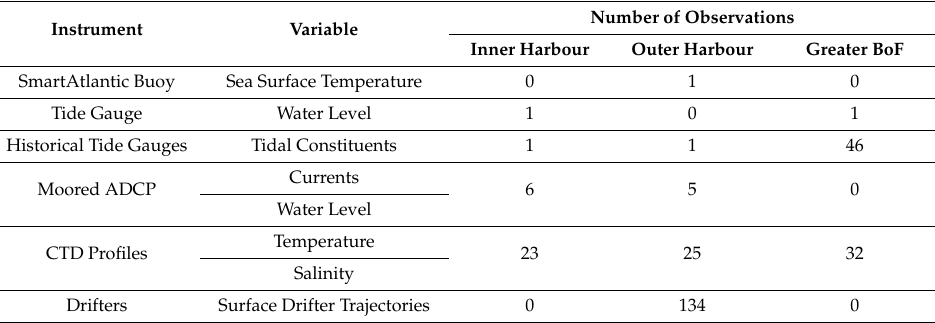
Table 1. A summary of the observations that were used for the